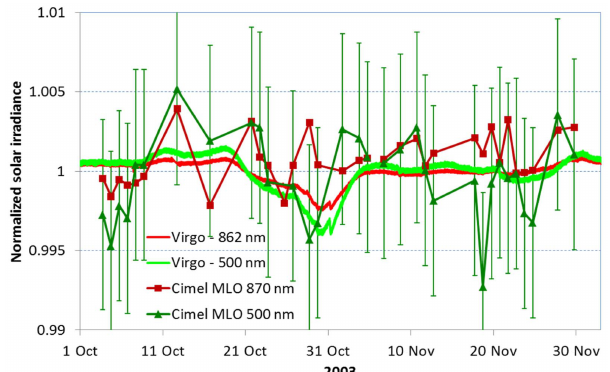
Figure 7. Solar extraterrestrial normalized irradiance as measured by the VIRGO space-based photometer during 2003–2004 at the 500nm (green) and 862nm (red) wavelengths. Cimel extraterres- trial signal derived from Langley plots at 500nm and 870nm in Mauna Loa for the same period are also depicted. Error bars for the 500nm channel indicate the 0.7% typical uncertainty for this spectral